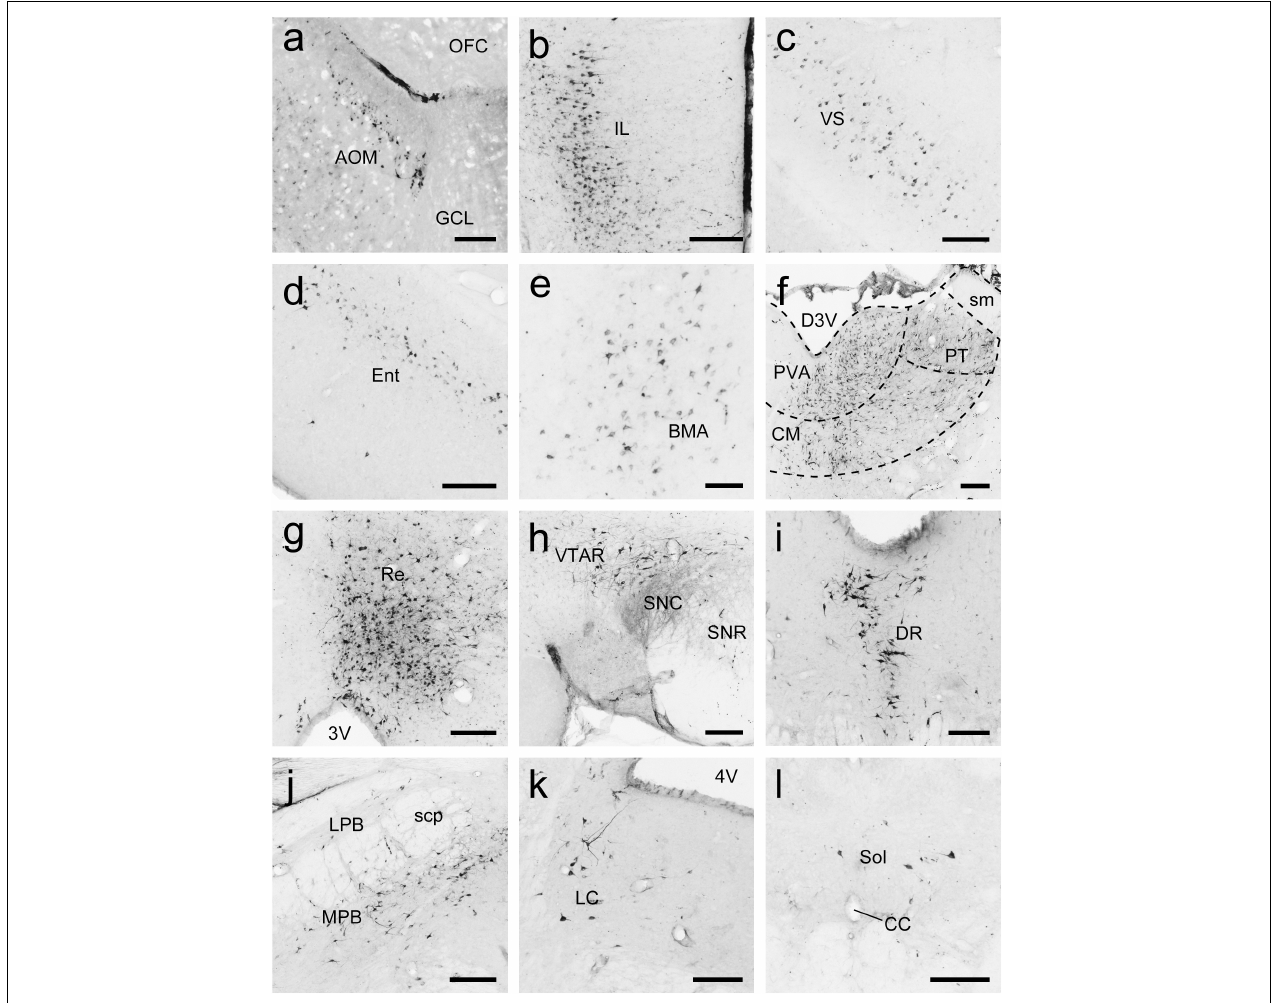
FIGURE 10 | Photomicrographs of coronal sections through the whole brain of tree shrews showing the distribution patterns of FG-labeled neurons projecting to the accumbens nucleus (Acb) in the medial part of the anterior olfactory nucleus (AOM; a ), infralimbic cortex (IL; b ), ventral subiculum (VS; c ), entorhinal cortex (Ent; d ), basomedial amygdaloid nucleus (BMA; e ), thalamus (f) , reuniens thalamic nucleus (Re; g ), rostral part of the ventral tegmental area (VTAR; h ), dorsal raphe nucleus (DR; i ), parabrachial nucleus ( j ), locus coeruleus (LC; k ), and solitary nucleus (Sol; l ). The dashed line marks the boundaries between brain regions (d) . Scale bars = 200 µ m in (a–d,f–l); 100 µ m in (e)